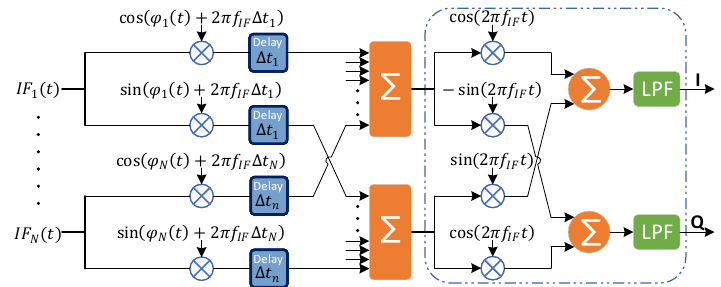
Figure 11. Block diagram of the IF-DBF